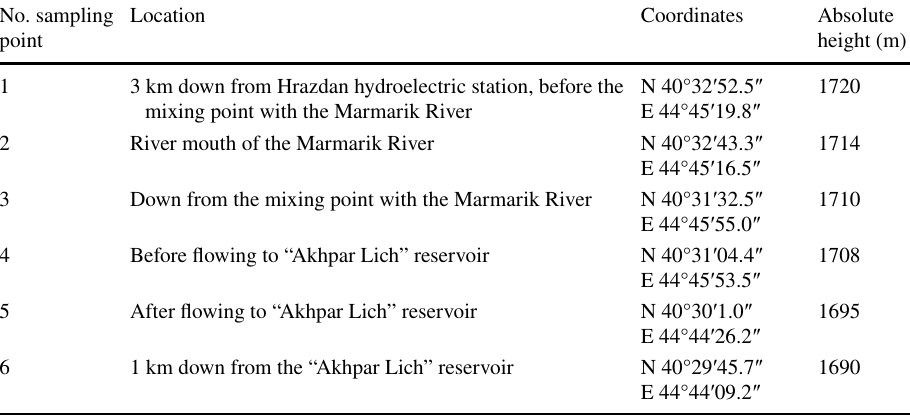
coordinates of sampling points